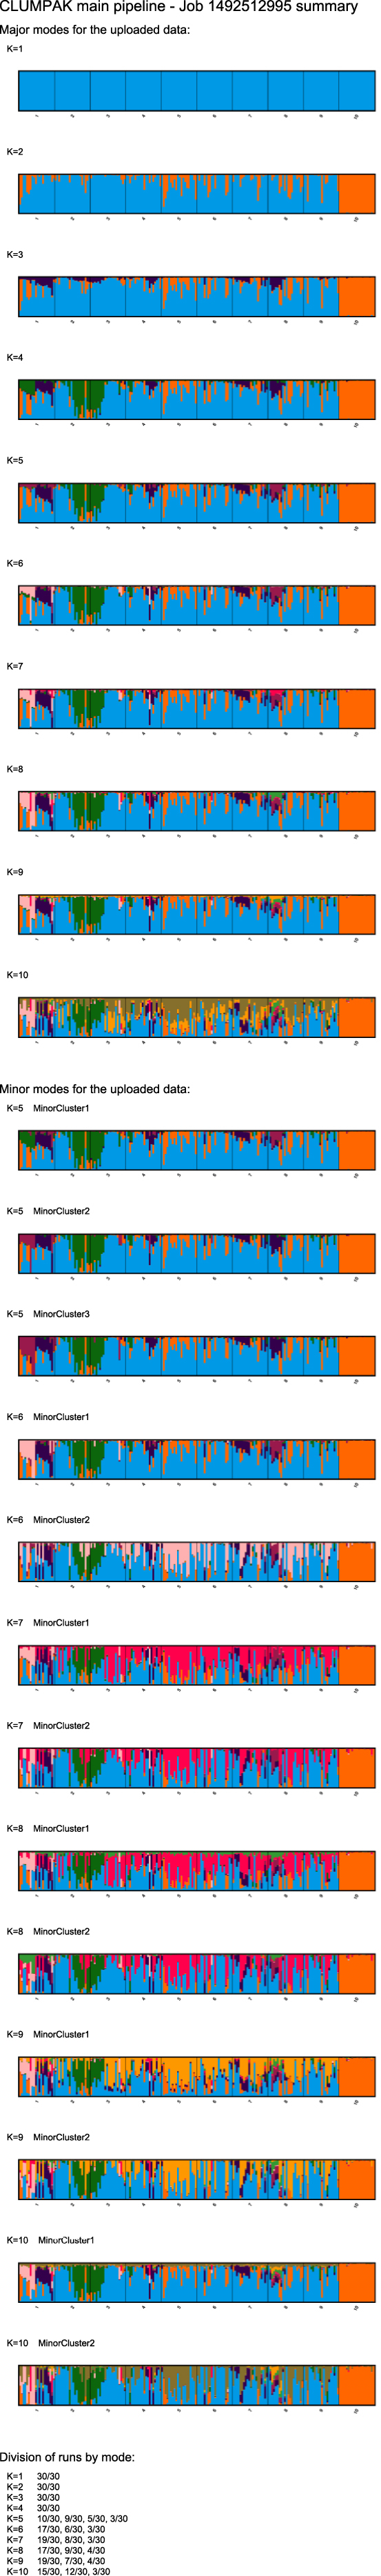
Results of cluster analysis of composition of ISSR loci of G. conopsea obtained with the Structure program for all 10 populations using the “admixture” model. The numbers on the X-axis indicate the numbers of populations (see Table 1).